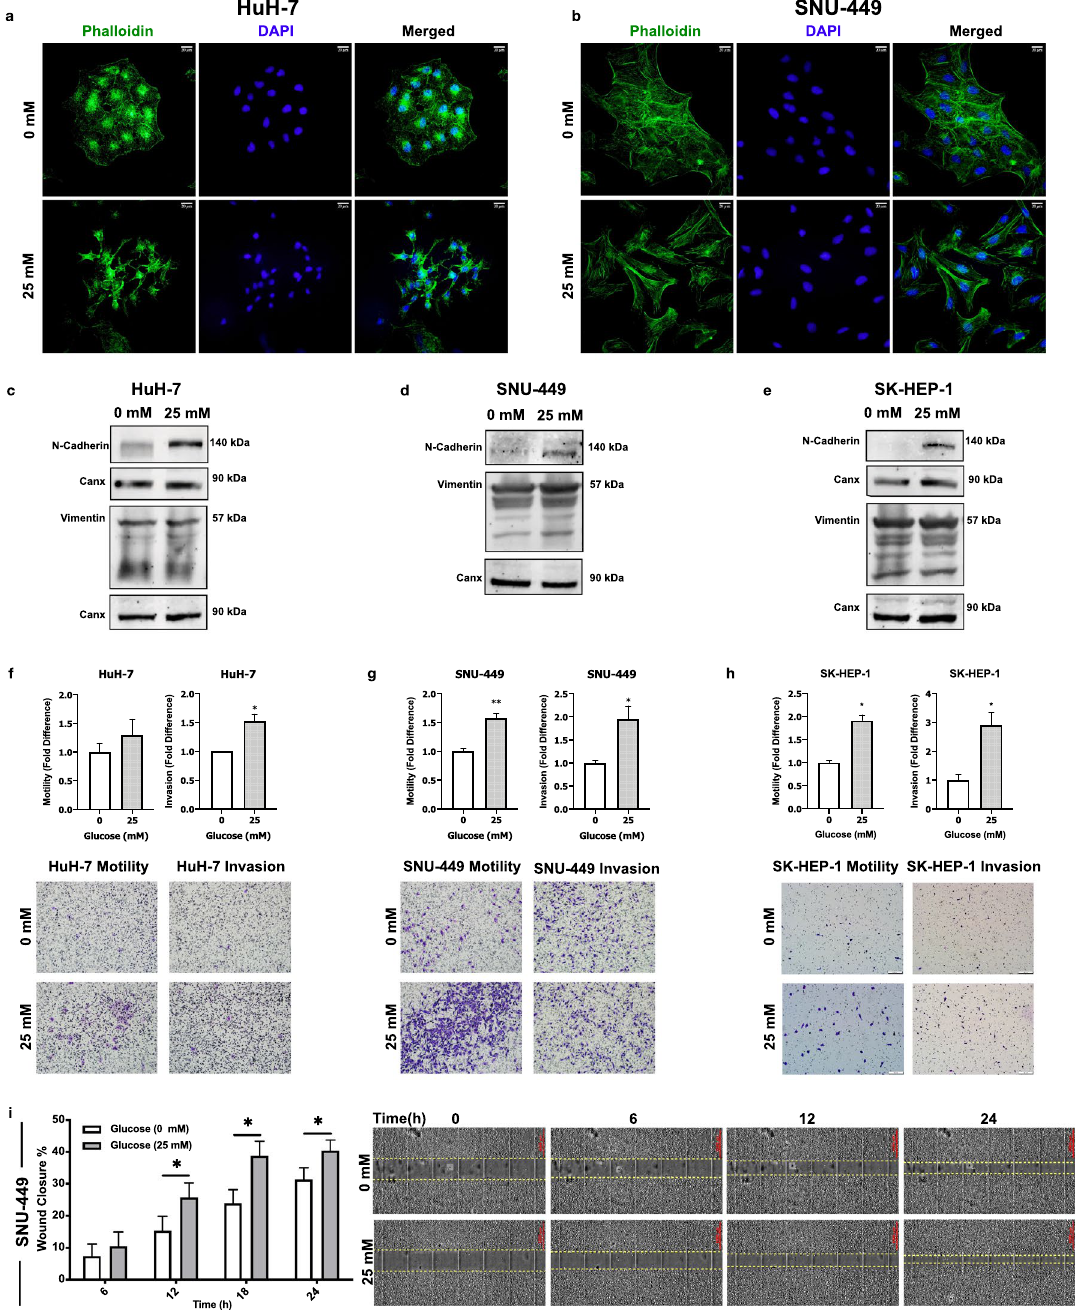
Figure 1. High glucose promoted mesenchymal phenotype and induced motility and invasion in HCC cell lines. Immunofluorescence imaging of Alexa-488-conjugated Phalloidin labeling of F-actin stress fibrils in ( a ) HuH-7 and ( b ) SNU-449 cells in no- and high-glucose (25 mM) supplemented culture conditions. Immunoblotting of cell cytoskeleton EMT biomarkers N-cadherin and Vimentin expressions in ( c ) HuH-7, ( d ) SNU-449 and ( e ) SK-HEP-1 cells. Graphical presentation of fold difference in motility and invasion of ( f ) HuH- 7, ( g ) SNU-449 and ( h ) SK-HEP-1 cells cultured in no- and high-glucose supplemented media analyzed by trans-well motility and invasion assays. Graphical presentation of ( i , left) wound closure percentage of SNU-449 cells after 6-, 12-, 18- and 24-h incubation in no- and high-glucose supplemented culture conditions. Wound- healing graphical presentation represents 3 independent experiments. Combined microscopic images of ( i , right) SNU-449 wound healing assay from automated microscope for real-time live cell imaging on 0, 6th, 12th and 24th hours. Full length blots are presented in Supplementary. All graphs of experiments are presented as the mean ± SEM of at least 3 independent experiments. Statistical analyses were performed and column graphs were generated using GraphPad Prism version 8.2.1 for MacOS, GraphPad Software, San Diego, California USA, https:// www. graph pad. com . * p ≤ 0.05, ** p ≤ 0.01, *** p ≤ 0.001, **** p ≤ 0.0001